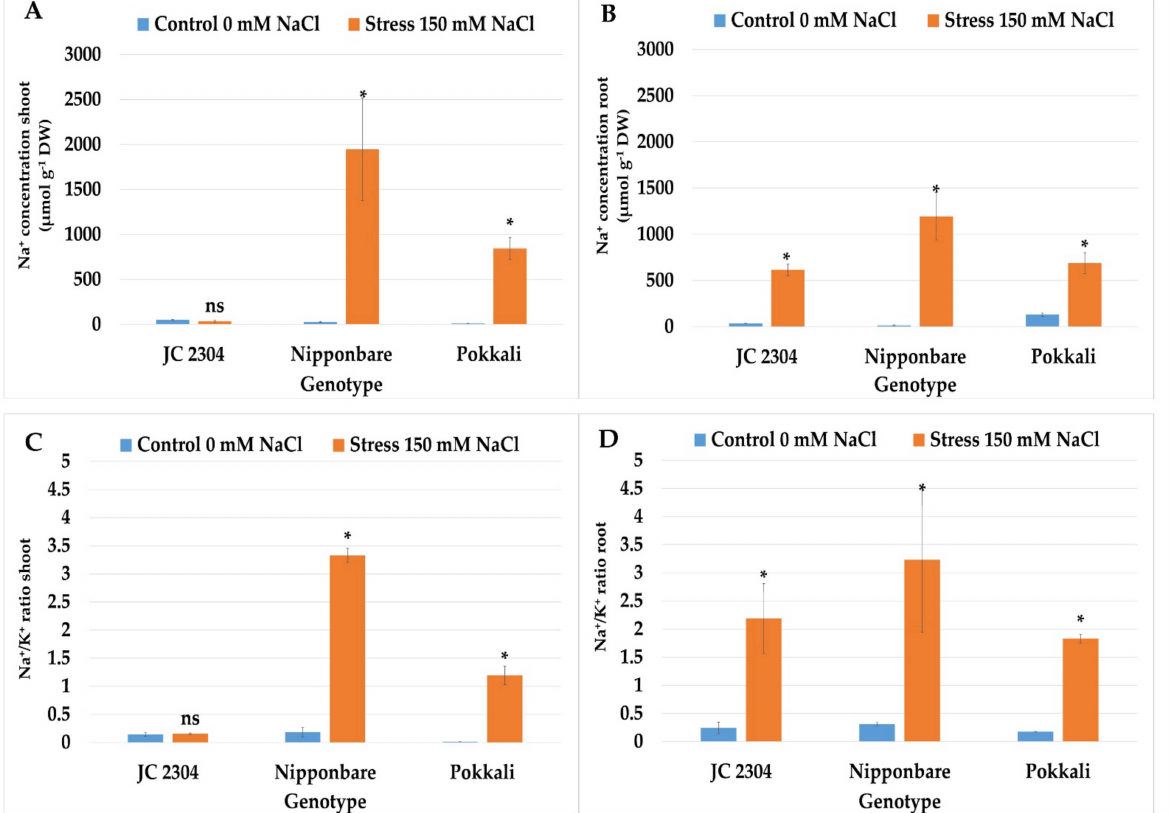
Figure 7. Effects of 150 mM NaCl on sodium and potassium contents in wild and cultivated rice seedlings after 14 days of stress. ( A ) Sodium content in shoots ( B ) Sodium content in roots. ( C ) Potassium content in shoots ( D ) Potassium content in roots. Data represent the means ± SE ( n = 9). Asterisks indicate the significant difference of salt-stressed plants with respect to non-stressed plants, based on the Student t -test (ns-not significant, * p ≤ 0.05). DW—dry